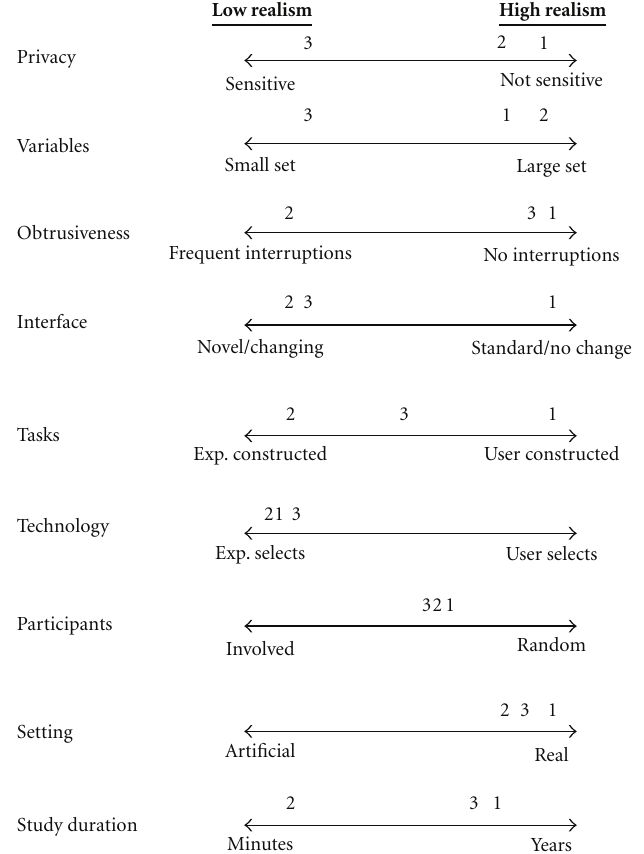
Figure 1: Three studies (1-current study, 2-experience sampling [52], 3-experimental [40]) that used smartphone logging to collect data and the approximate placements on each of the nine